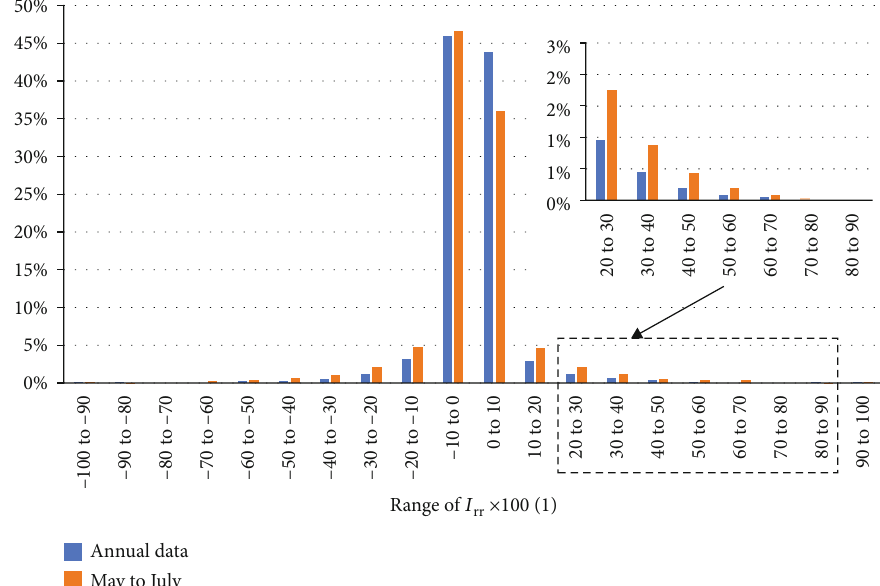
Figure 4: Histogram of the frequency of irradiance ramp rates in various ranges as measured across the entire year as compared to the interval May-July. The inset shows the higher incidence of larger ramp rates in the spring/summer months as expected.